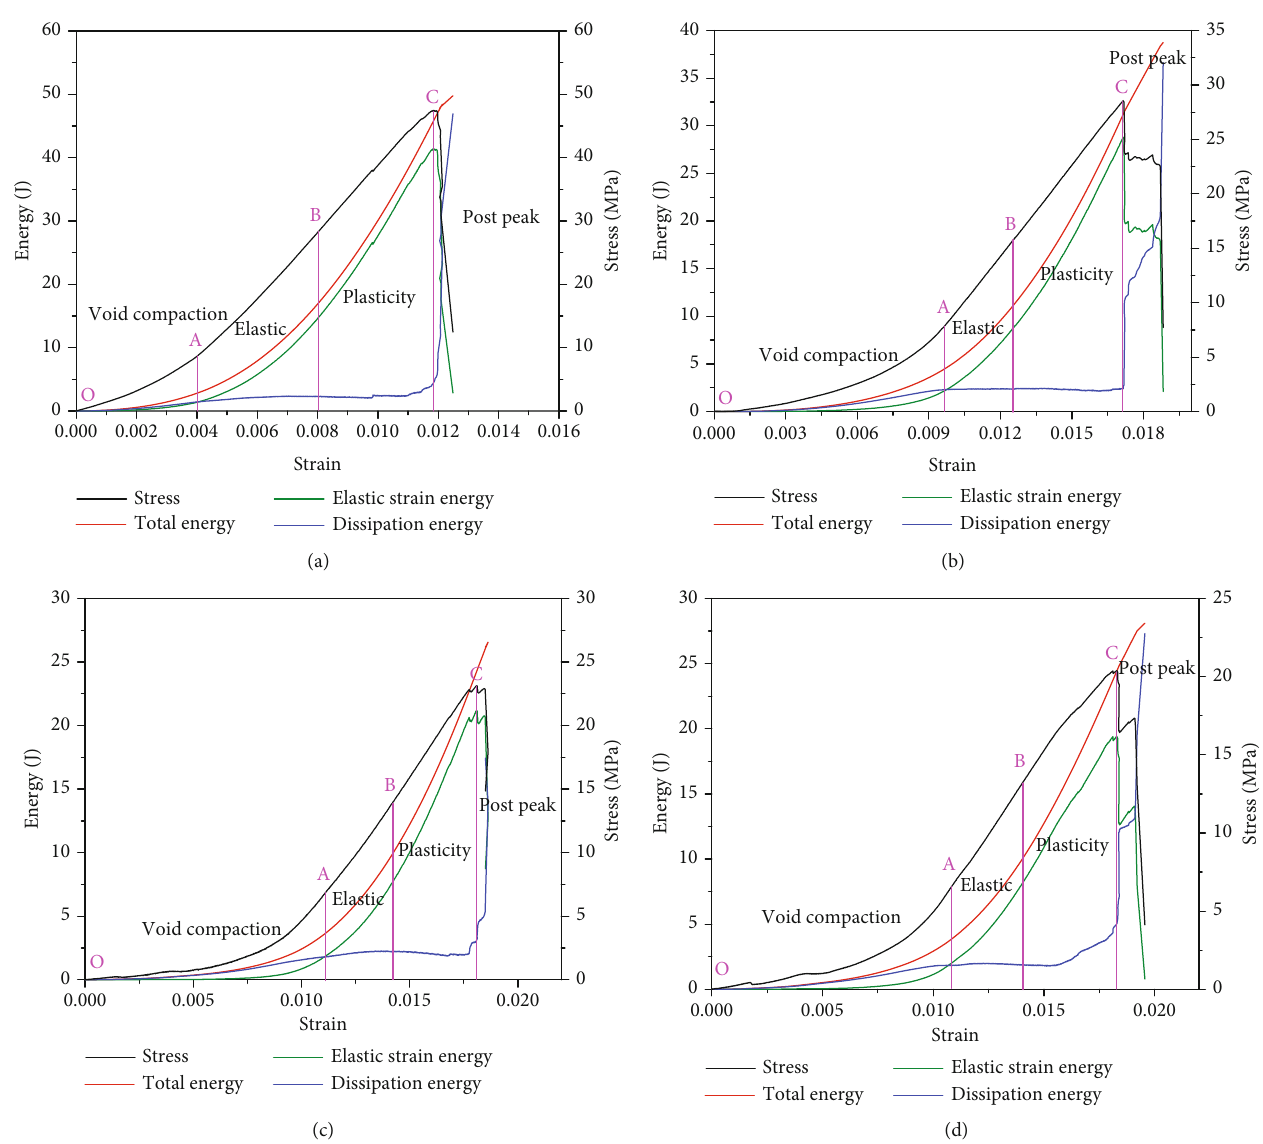
Figure 9: Energy variation of rock samples with di ff erent moisture content. (a) W0-1, (b) W1-1, (c) W2-1, and (d)